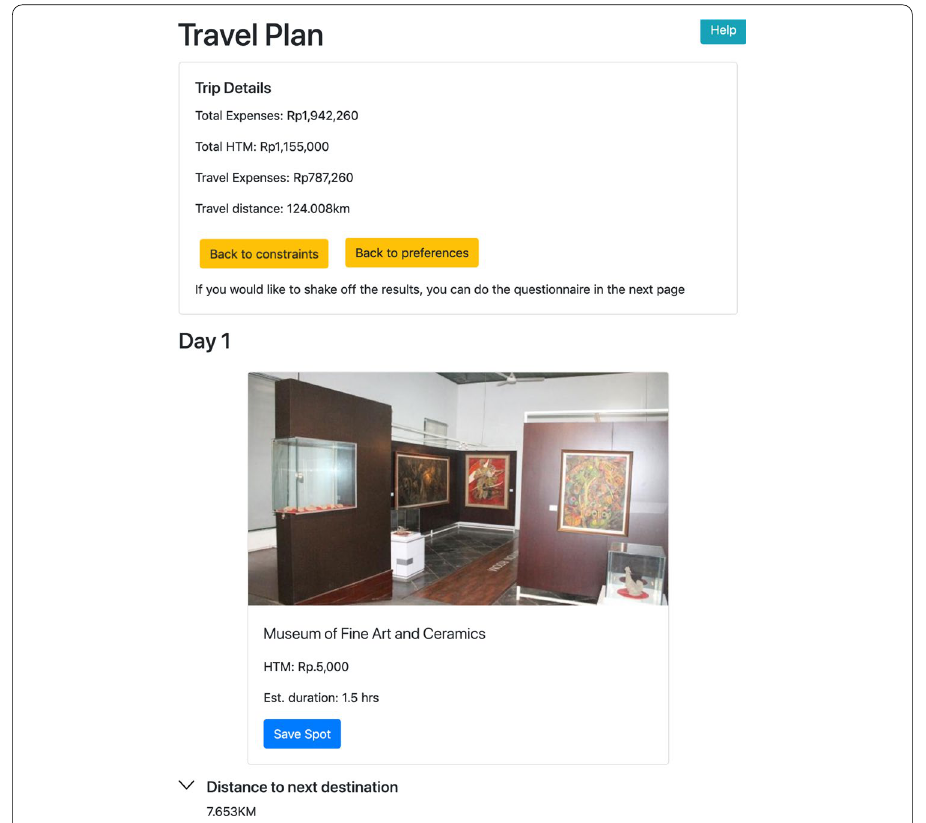
Fig. 5 UI design for list of trip